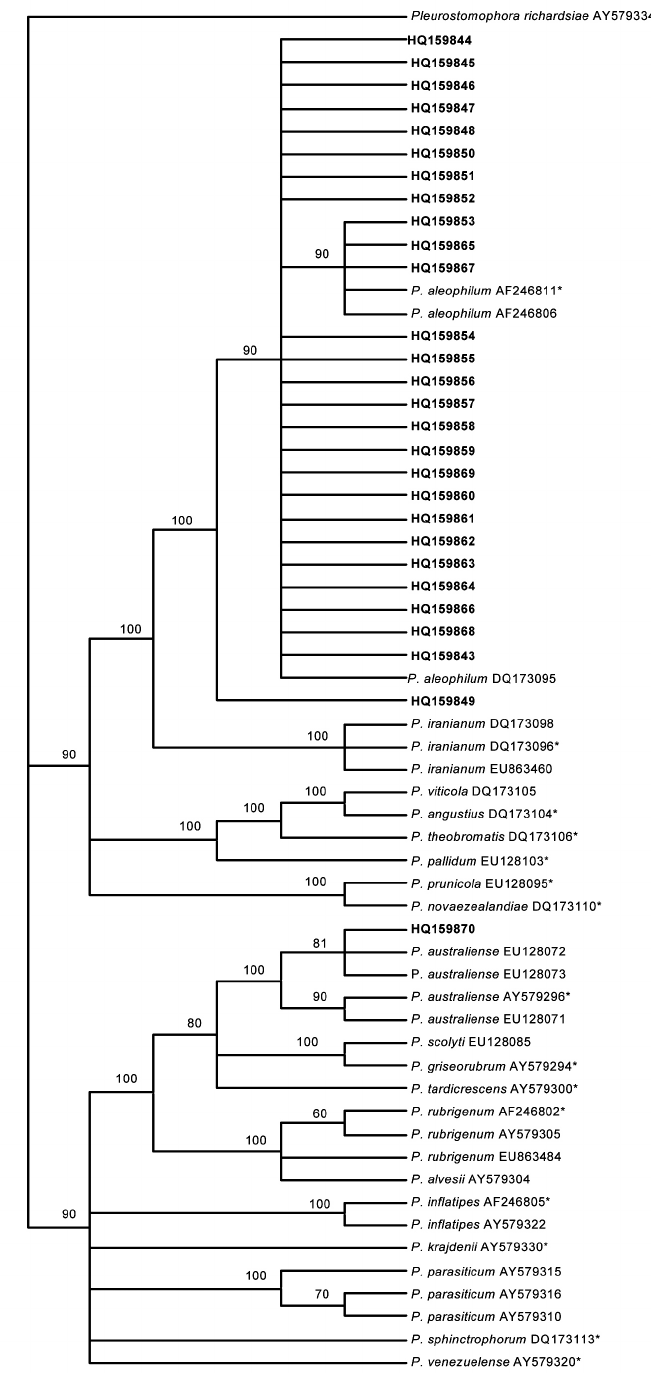
Figure 2. Fifty percent majority rule consensus phylogenetic tree obtained using β -tubulin sequences of Phaeoacr- emonium species obtained in the present study and from GenBank. GenBank numbers in bold were sequenced for the present analysis. Sequences from ex-type cultures are indicated by *. Bootstrap support values based on 1000 replicates are shown at the